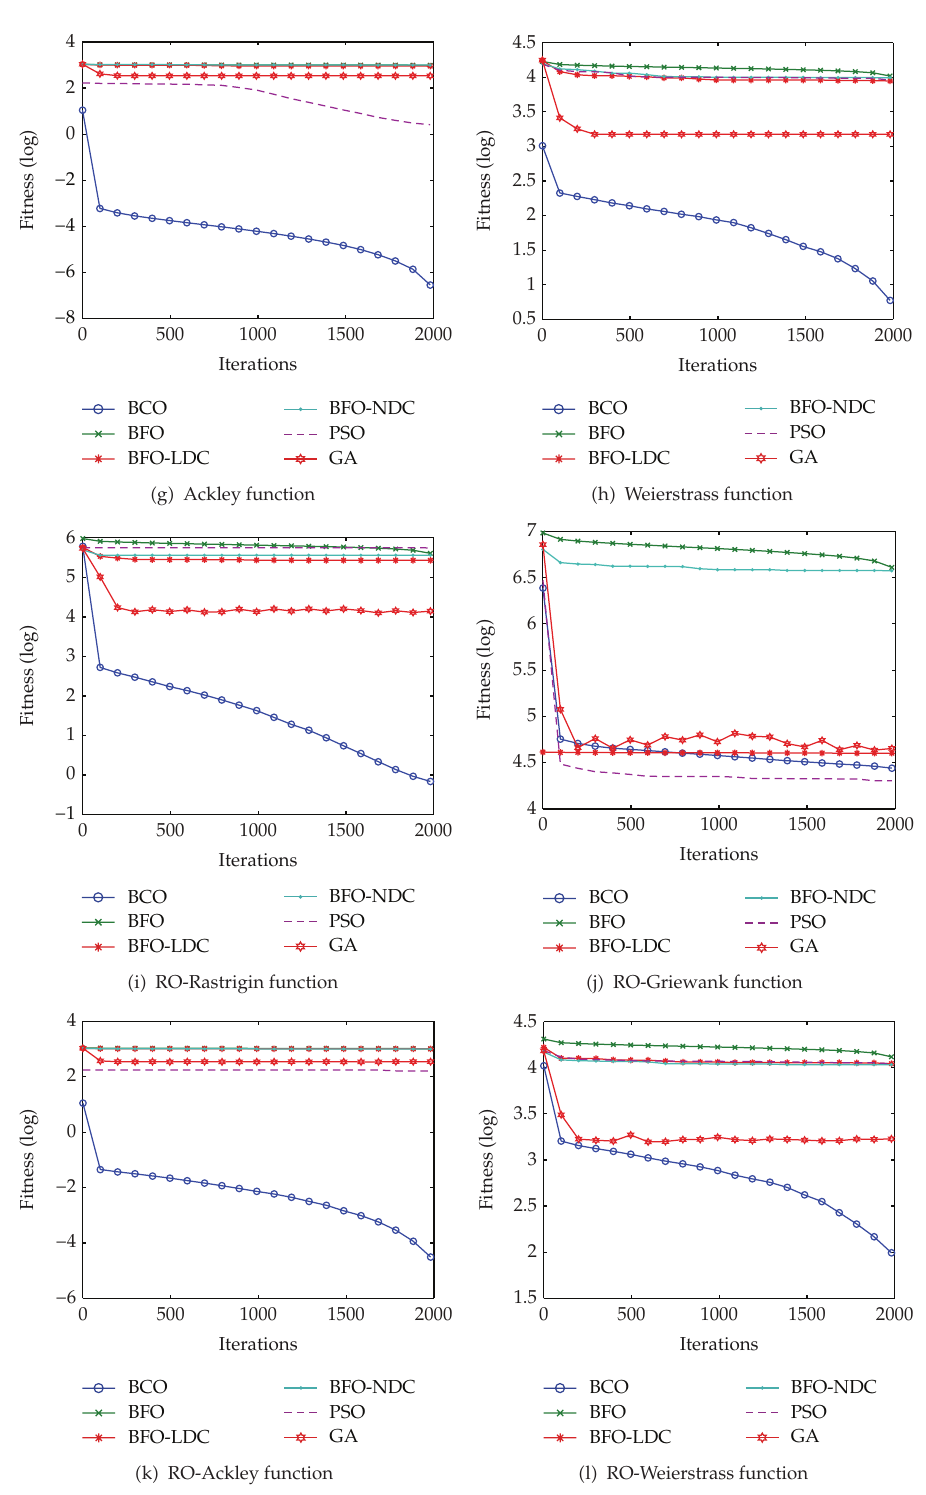
Figure 7: The median convergence characteristics of 40-D test